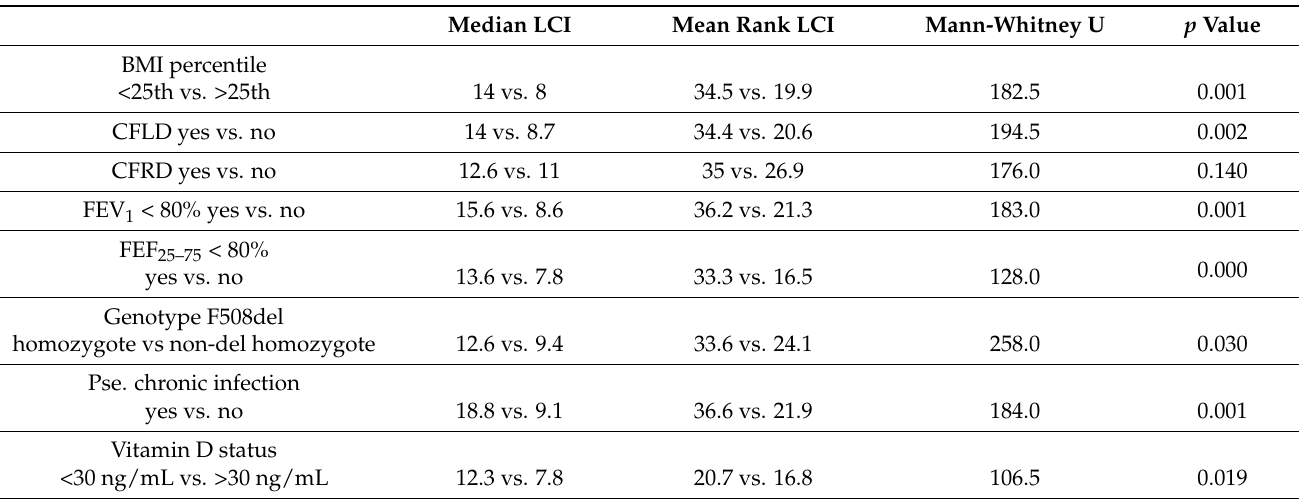
Table 4. LCI variability (Mann–Whitney U